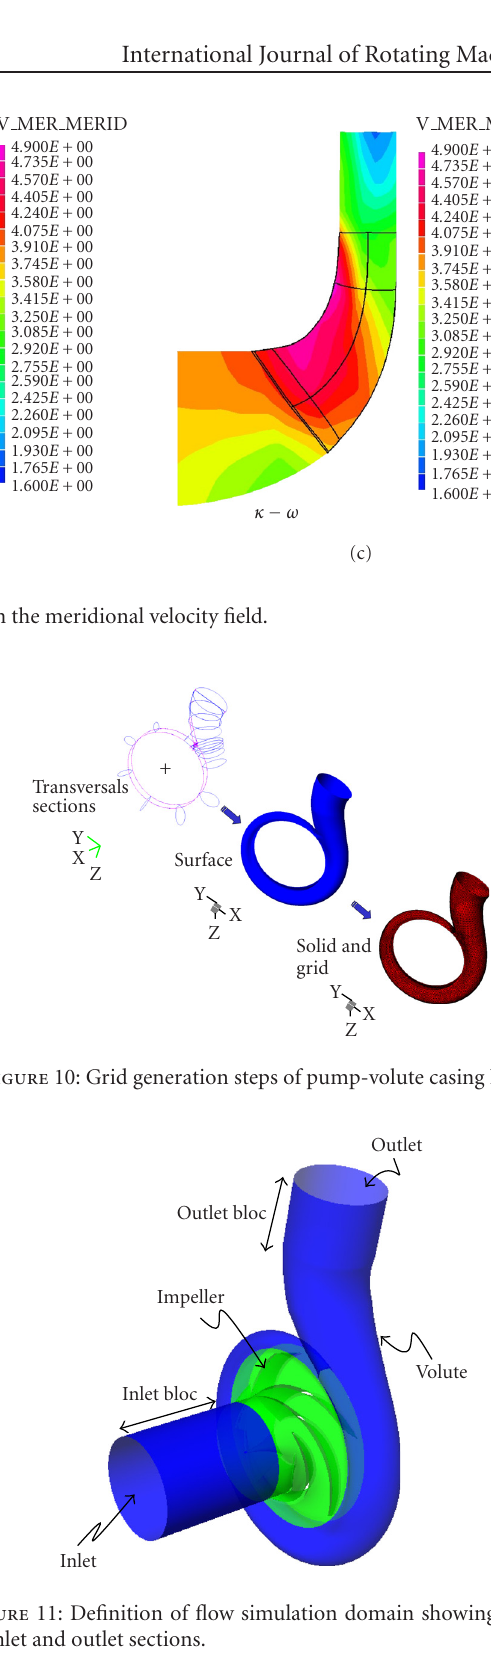
Figure 11: Definition of flow simulation domain showing extend of inlet and outlet